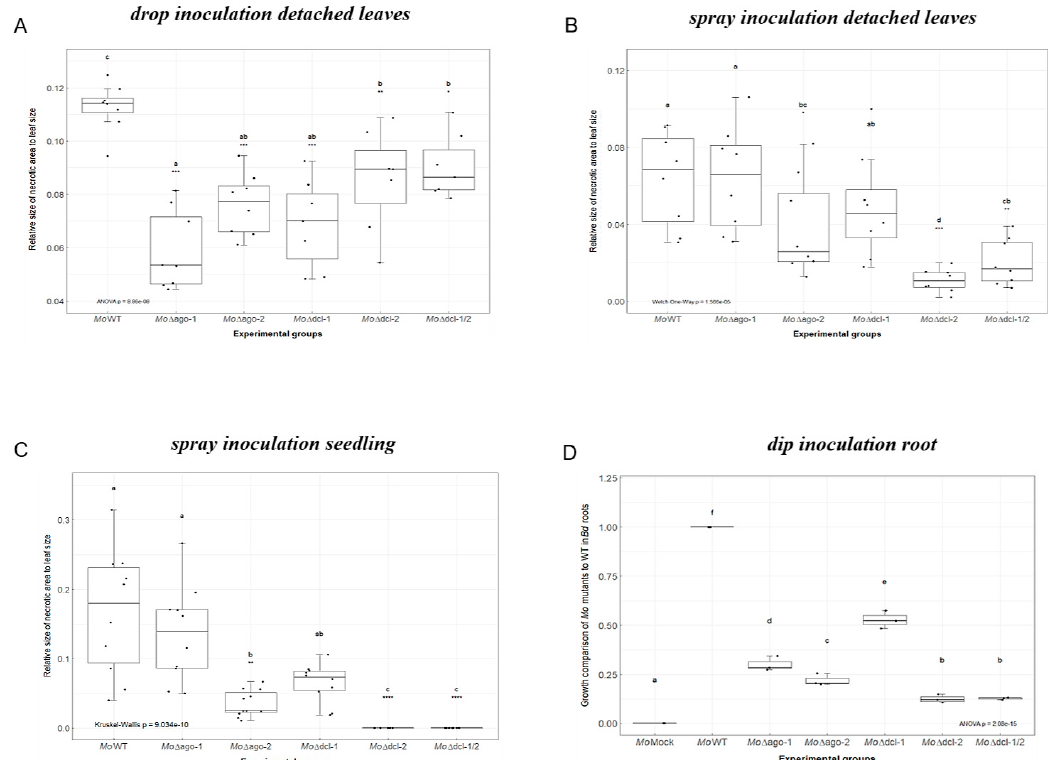
Figure 2. Infection assays of M. oryzae RNAi mutants. ( A ) Detached second youngest leaves of three-week-old Bd seedlings were drop inoculated with 10 µ L Mo conidia suspension 50 × 10 3 spores mL − 1 in 0.002% Tween20 and kept under high humidity at 16 h light/8 h dark cycle at 22 ◦ C/18 ◦ C. Fungal pathogenicity was assayed via ImageJ software at 5 DPI. The experiment was conducted two times ( n = 8 plants per experimental group) with similar results. Comparisons between groups was performed via ANOVA and Tukey’s range test for multiple comparisons. ( B ) Detached Bd leaves were spray inoculated with a total of 250 µ L Mo conidia suspension 50 × 10 3 spores mL − 1 in 0.002% Tween20 and kept and evaluated as in (A). The experiment was conducted two times ( n = 8 plants per experimental group) with similar results. Comparisons between groups was performed via Welch one-way test coupled with pairwise t-tests with Benjamini–Hochberg p -value adjustment. ( C ) Three-week-old Bd seedlings were spray inoculated with Mo conidia suspension 120 × 10 3 spores mL − 1 in 0.002% Tween20 and kept and evaluated as in (A). The experiment was conducted two times ( n = 18 plants per experimental group) with similar results. Comparisons between groups was performed via Kruskal–Wallis test and Dunn’s test of multiple comparisons. ( D ) Roots of seven-day-old Bd seedlings were inoculated with 1 mL of Mo conidia suspension 125 × 10 3 spores mL − 1 in 0.002% Tween20 for 3 h. Afterwards, seedlings were transplanted in small pots (3 cm Ø) and grown for an additional 5 days before harvesting. Fungal amount was calculated by qPCR based on the ratio of fungal actin ( MoActin ). The experiment was conducted two times ( n = 6 roots per experimental group) with similar results. Comparisons between groups was performed via ANOVA and Tukey’s range test for multiple comparisons. ( A – D ) Letters represent statistical difference among all groups’ means ( α < 0.05). Asterisks represent statistical difference of each group against wildtype (wt) (* p < 0.05; ** p < 0.01; *** p < 0.001; **** p <